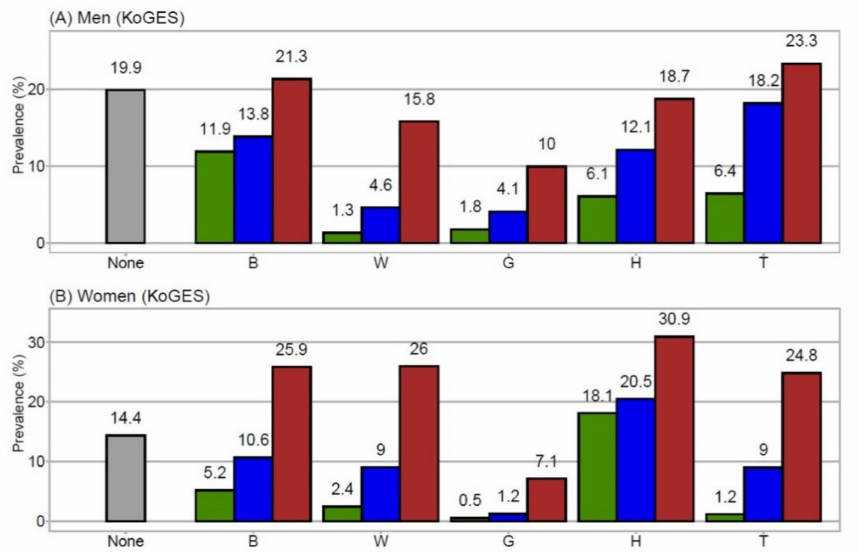
Figure 1. This is a figure. Schemes follow the same formatting. ( A ) prevalence in men, ( B ) prevalence in women. Grey bars indicate the prevalence of subjects with no MetSyn components (i.e., non- MetSyn patients). Green bars represent the prevalence of subjects with only one MetSyn component (B, W, G, H, or T). Blue bars represent the prevalence of subjects with a specific component plus one other MetSyn component. Brown bars represent the prevalence of subjects with a specific component plus two or more other MetSyn components (i.e., MetSyn patients). Numbers located above the bars indicate the numerical prevalence values. B, elevated blood pressure; G, elevated glucose; H, low HDL-cholesterol; KoGES, Korean Genome and Epidemiology Study Ansan and Ansung; MetSyn, metabolic syndrome; T, elevated triglycerides; W, increased waist